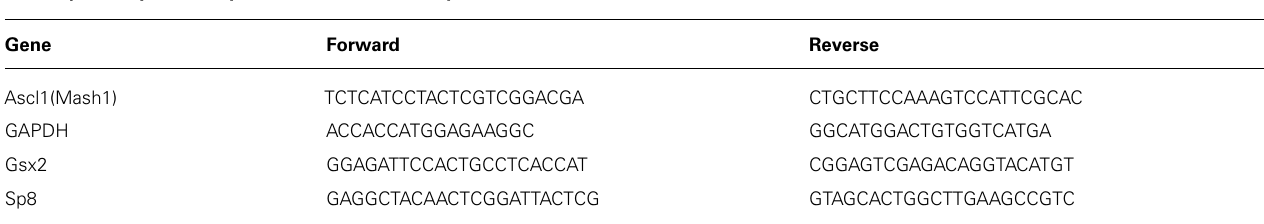
Table 3 | List of primer sequences used in the study.